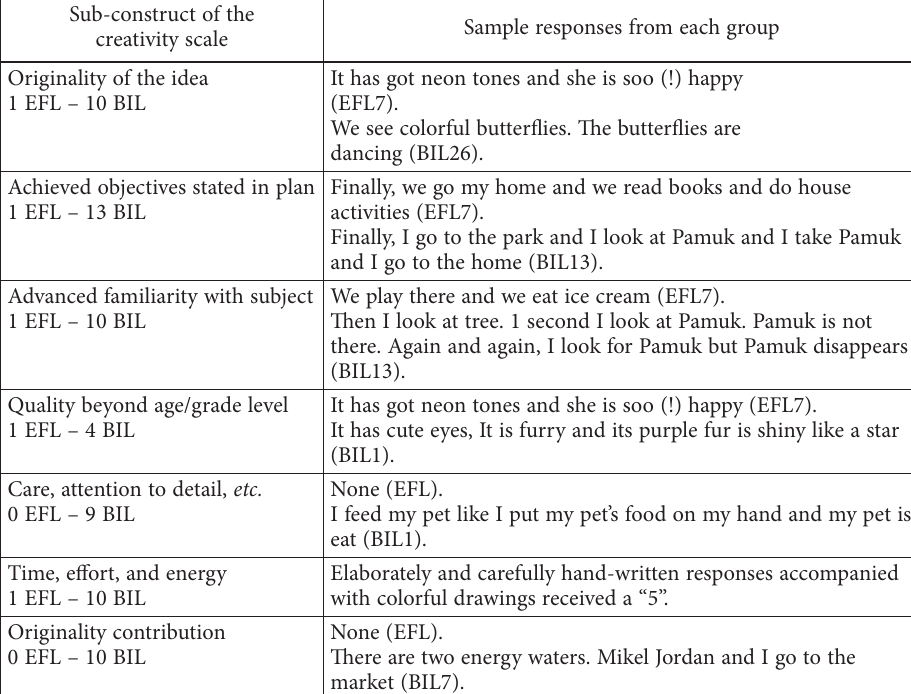
Table 9. Number of the highest-scoring (5 = outstanding) students according to creativity sub-con- structs and their sample responses (English as foreign language – EFL, bilingual – BIL) (source: